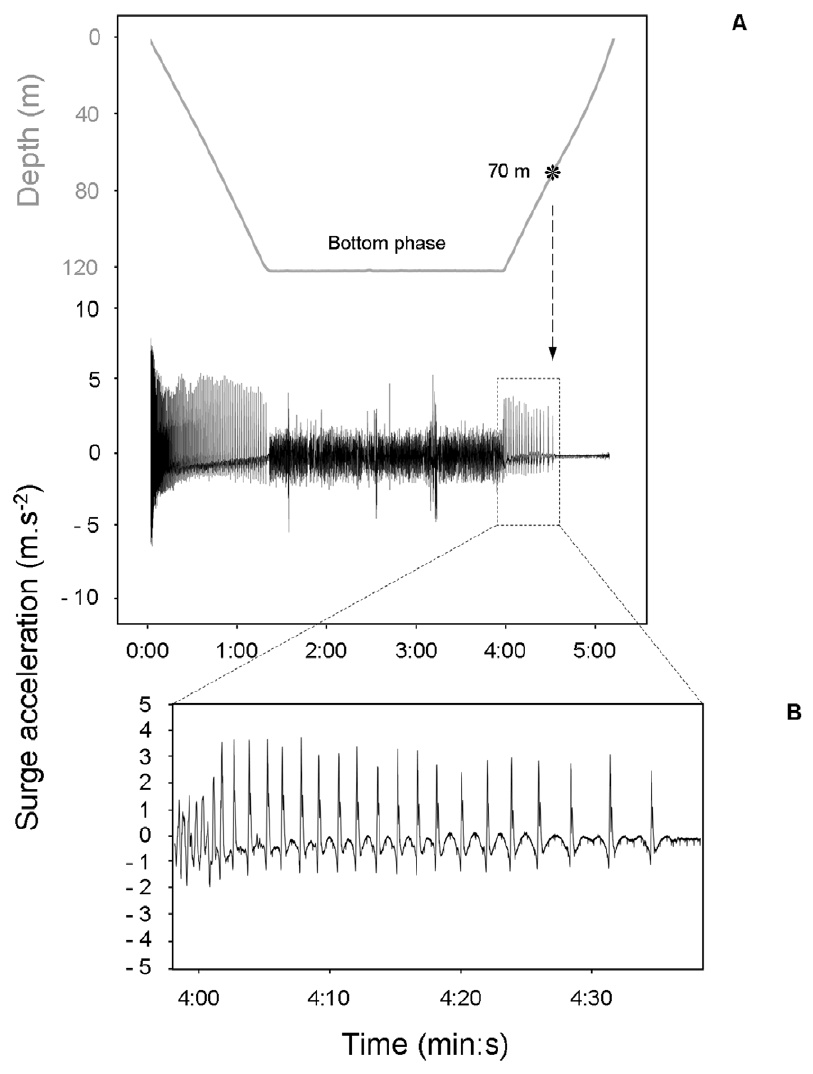
Figure 6. (A) Example for one bird of how paddling activity, represented by surge acceleration, varies in relation to dive phase and (B) close up of the first part of the ascent phase. The vertical excursions during the bottom phase are not similar to the paddling activity that occurs during the descent or the ascent. This noise is the result of a combination of different complex body movements produced by the bird, which include fish hunting and horizontal swimming. Note how stroking activity is intense during the first 1–2 s of descent. In this example, the bird performed 20 foot-strokes to swim from the bottom to a depth of 70 m (each stroke triggered a peak in surge acceleration). The bird reached the surface afterwards through passive